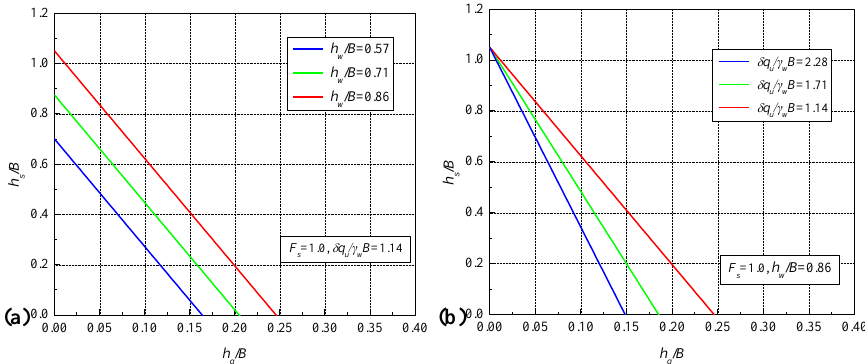
Figure 5. Relation curves of h g / B versus h g / B when considering “instability failure”: ( a ) water table; and, ( b ) unconfined compression strength.